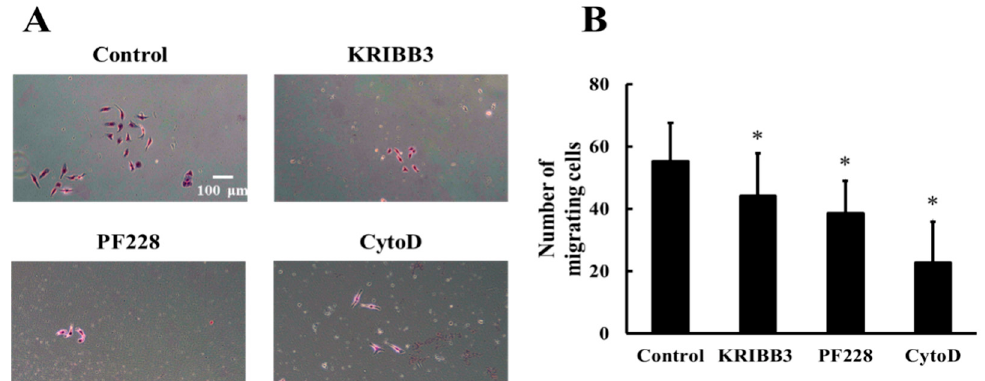
Figure 7. Effect of HSP27 on shear-stress-induced cell migration. ( A ) Shear-stress-induced cell migration images in the control, KRIBB3, PF228, and CytoD groups. ( B ) Comparison of cell migration numbers between the control and other groups under shear stress (* p < 0.05 when comparing to the control; n = 5 for all groups).